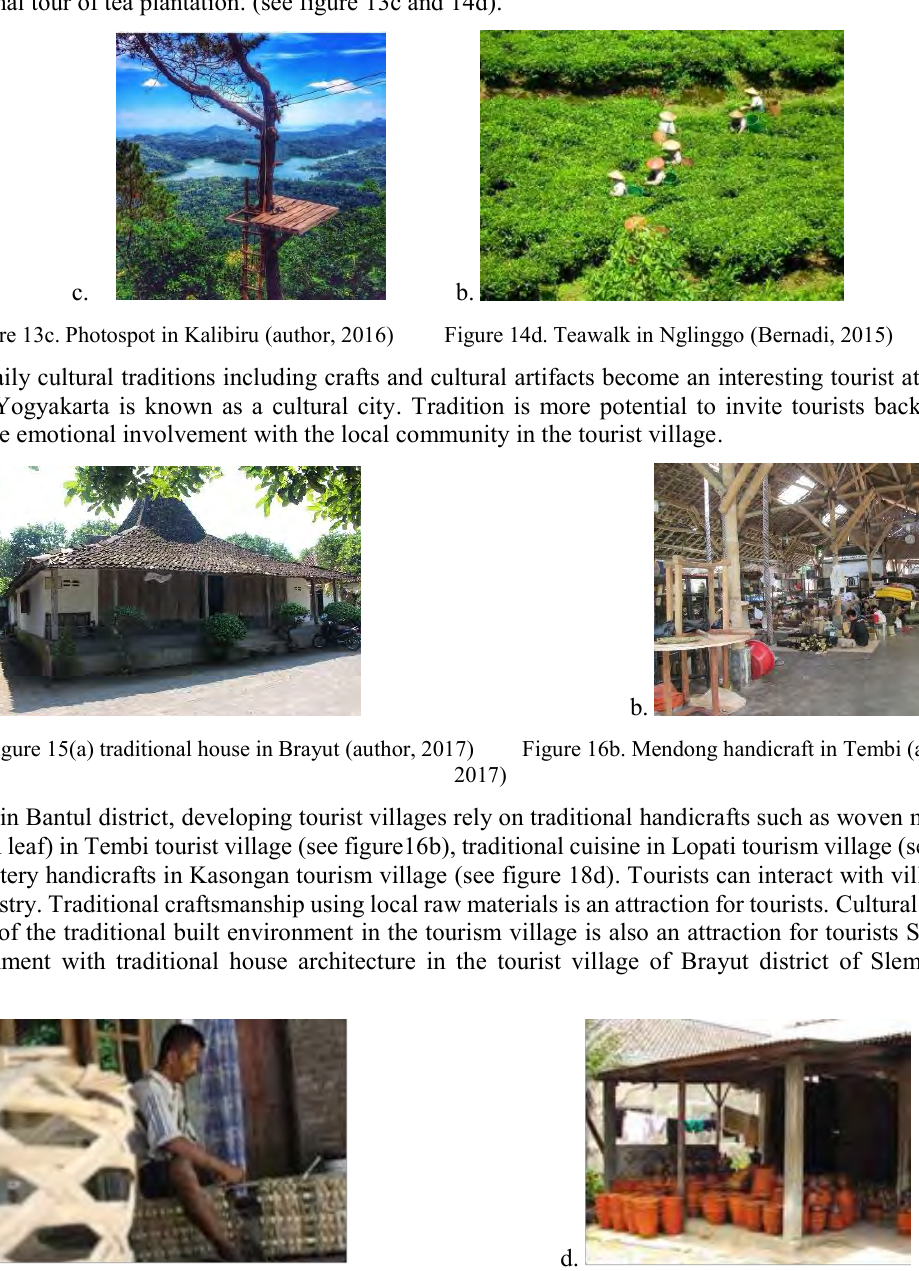
Figure 17c. bamboo basket in Lopati (Ipank, 2012) Figure 18d. Pottery handicraft in Kasongan (Farhan,